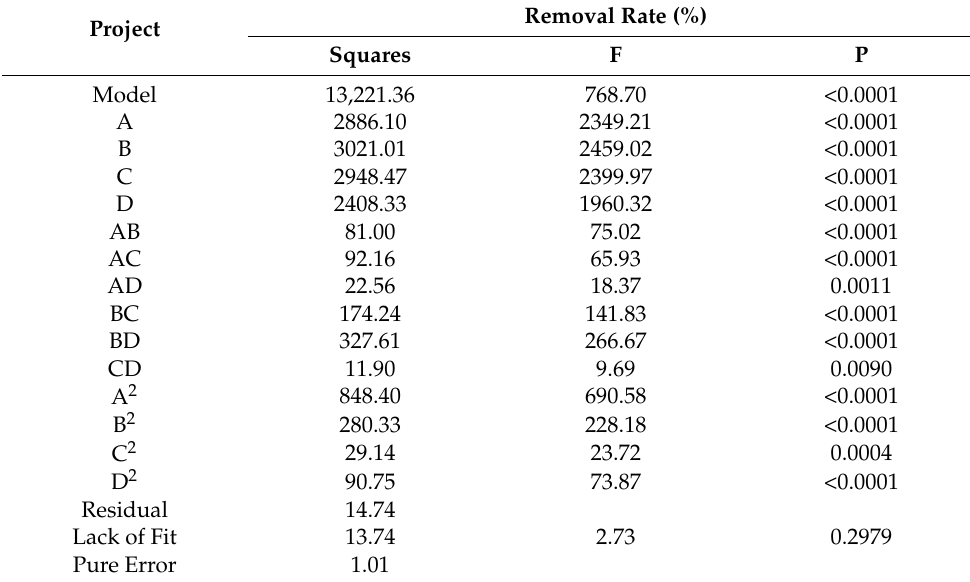
Table 5. Analysis of